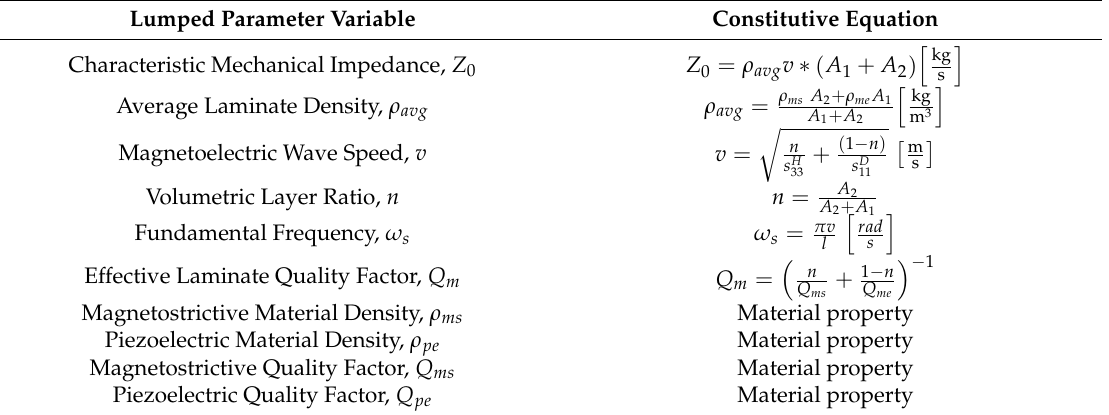
Table 1. Lumped parameter equations for L-L magnetoelectric (ME) laminate. Adapted from [15]. Lumped Parameter Variable Constitutive